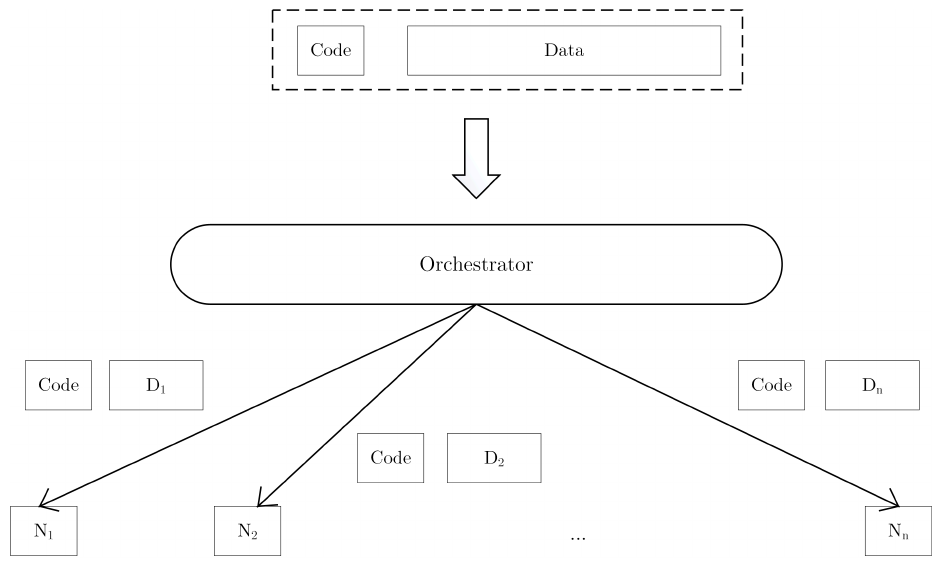
Figure 1. Orchestration